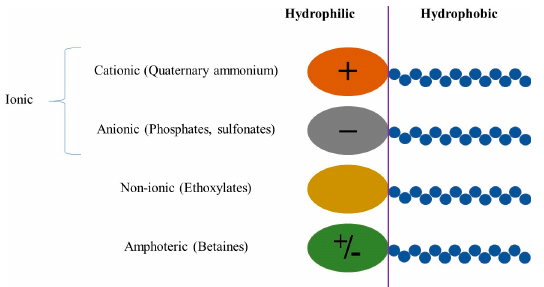
Figure 1. Types of biosurfactants based on the polarity of the head group. Source: the author .